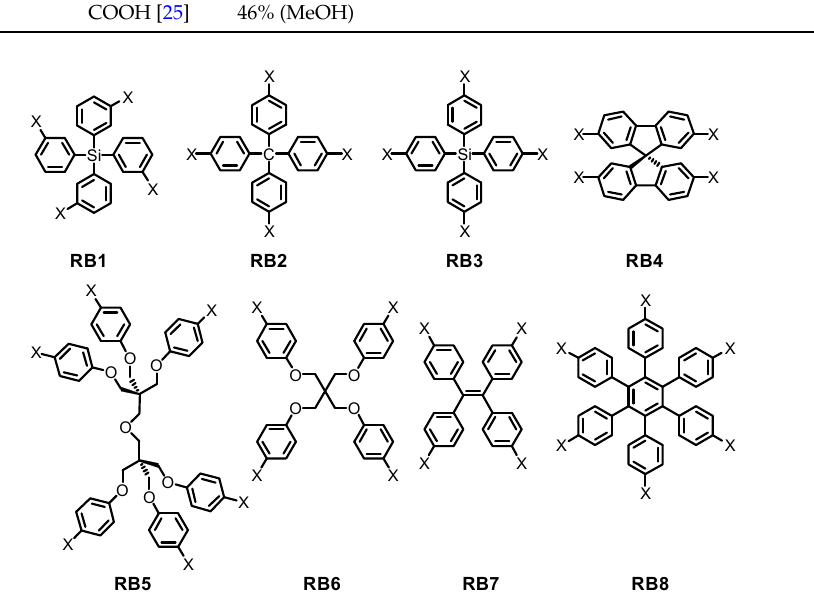
Figure 2. Structures of rigid and flexible scaffolds RB1 – 8 .